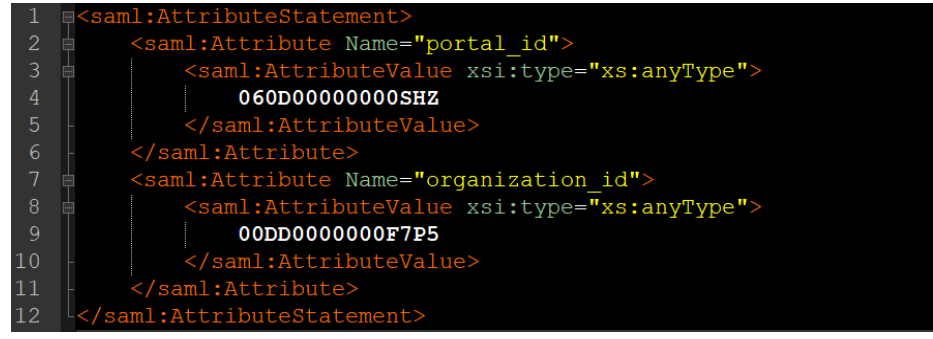
Table 1. Specification of the